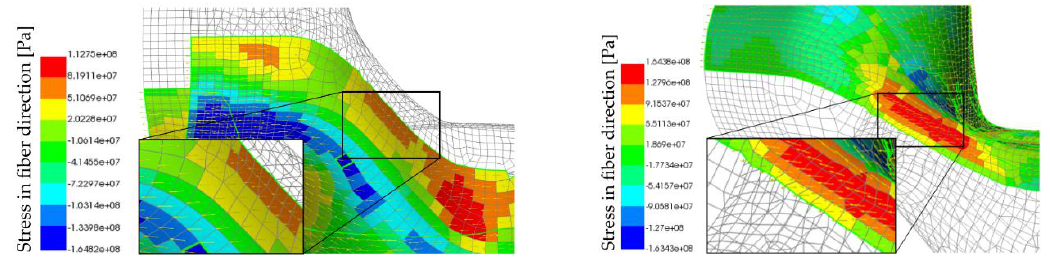
Figure 18. Stresses and result of load evaluation according to Cuntze for as-planned configuration.